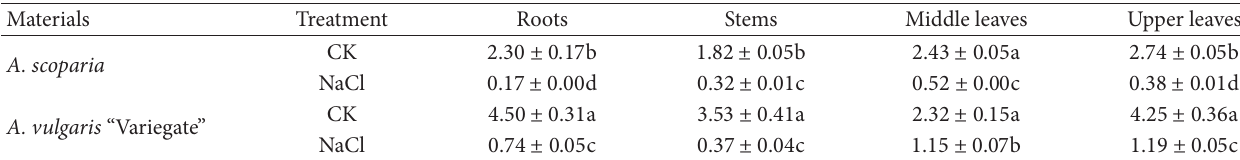
Table 7: Effect of NaCl stress on the ratios of Ca 2+ /Na + in different parts of